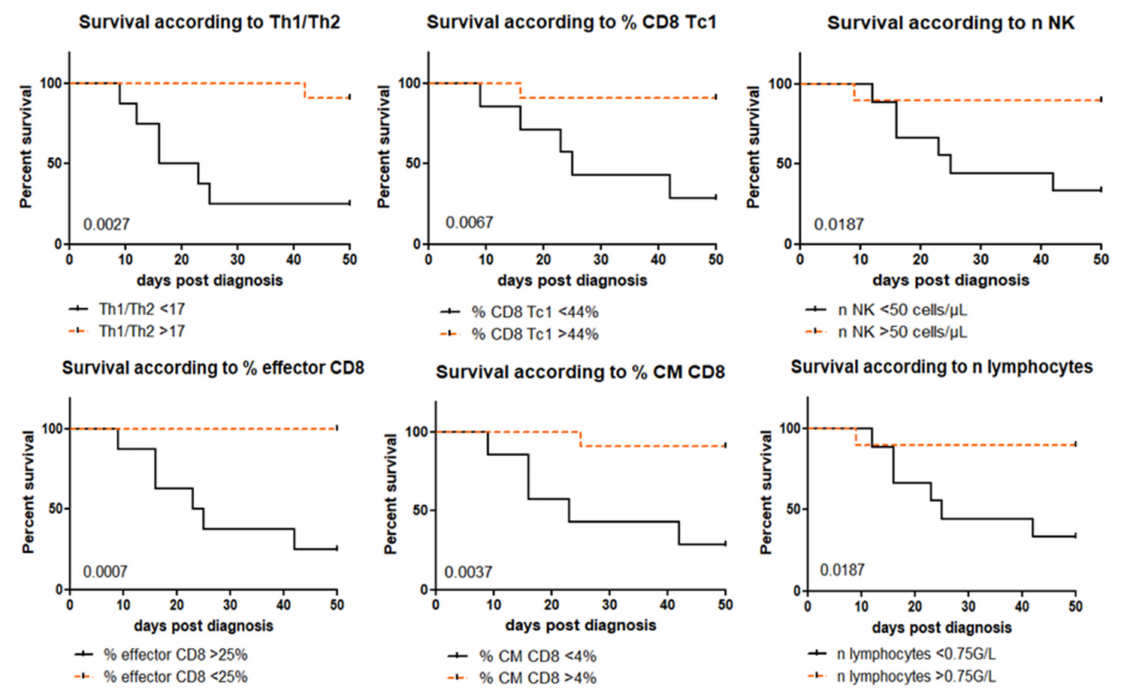
Figure 1. Kaplan–Meier survival curves. p -values are added in the lower left corner of the graphs (Mantel–Cox